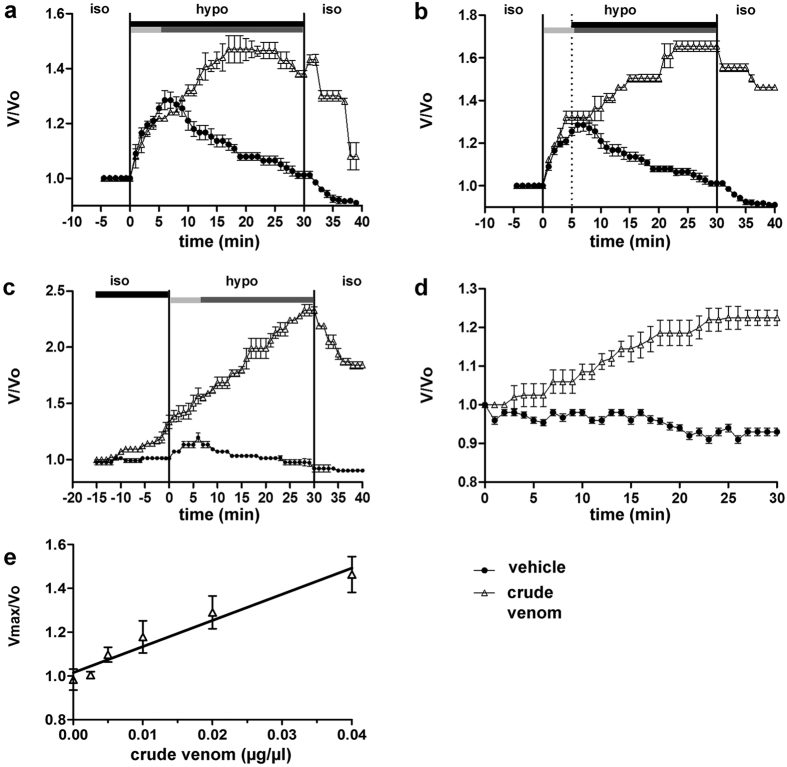
Crude venom affects the regulation and maintenance of volume in HEK 293 Phoenix cells.Cell volume, as V/V0 or Vmax/V0, is plotted against time or venom concentration. (a–c) Vehicle-treated cells exposed to a hypotonic challenge exhibited the expected swelling (osmotic phase, light grey bars), reaching a V/V0 peak value after a 6 min exposure to the hypotonic solution, and subsequently regulated their volume (RVD phase, dark grey bars) towards the value initially observed in isotonic solution. Addition of 0.025 μg/μl crude venom to the hypotonic solution (either from the beginning, (a) or after a 5 min exposure to the hypotonic solution, (b) dotted line) led to dramatic cell swelling and completely prevented RVD. (c) pre-incubation of cells for 15 min in isotonic solution containing crude venom lead to dramatic cell swelling and abrogated RVD during a subsequent exposure to a hypotonic solution not containing crude venom. (d) Exposure of cells to an isotonic solution containing crude venom led to significant cell swelling. After 30 min, V/V0 for vehicle and venom-treated cells was respectively 0.93 ± 0.01, n = 4, and 1.23 ± 0.02, n = 4, p < 0.0001, unpaired Student’s t test. (e) Cells exposed to increasing concentrations of crude venom exhibited dose-dependent volume changes; n = 6–12 for each data point. Black bars in (a,b and c) indicate the presence of crude venom or the vehicle in the experimental solutions. Iso, isotonic solution 1 (Table 1); hypo, hypotonic solution 2 (Table 1). Refer to Supplementary Table 1 for statistics of panels a, b and c.